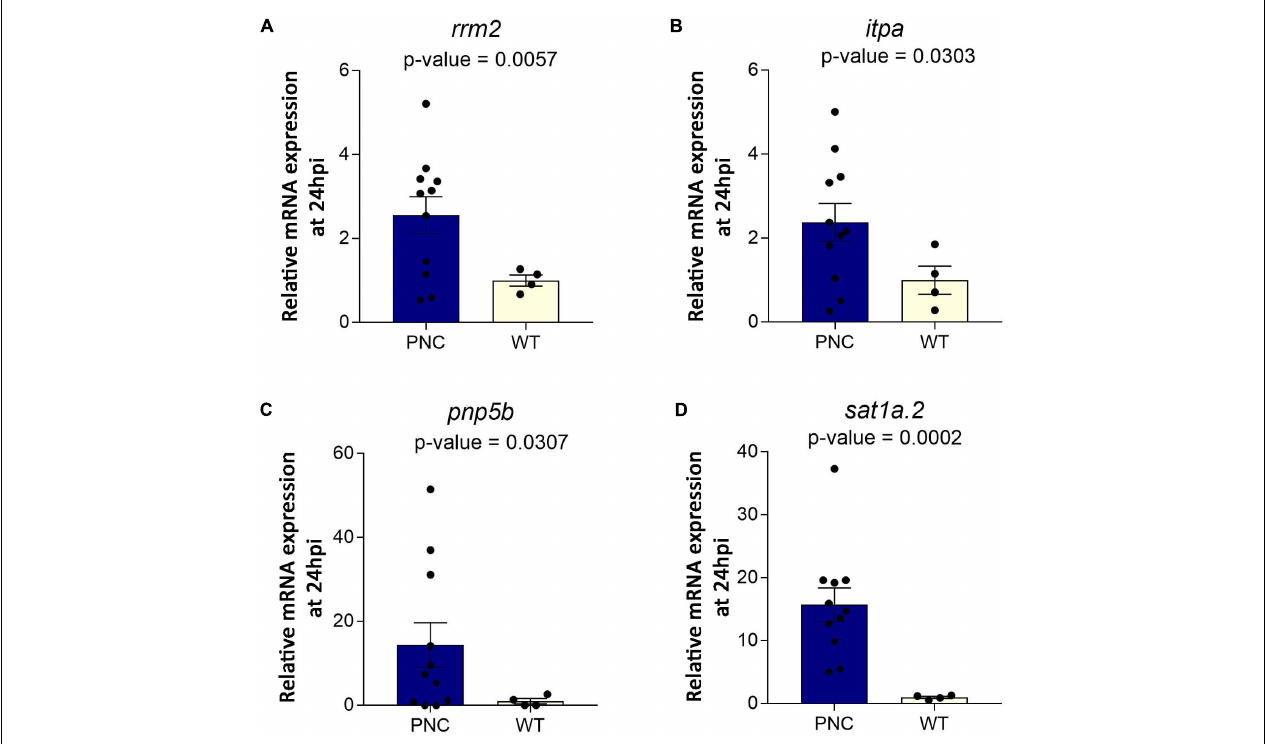
FIGURE 7 | Upregulation of genes encoding metabolic enzymes at 24 h post HRAS G12V induction in PNCs. Relative mRNA expression normalized to β -actin showing (A) rrm2 ( p = 0.0057), (B) itpa ( p = 0.0303), (C) pnp5b ( p = 0.0307), and (D) sat1a.2 ( p = 0.0002) expression was increased in PNCs. PNC N = 11, Control N = 4, Welsh’s t-